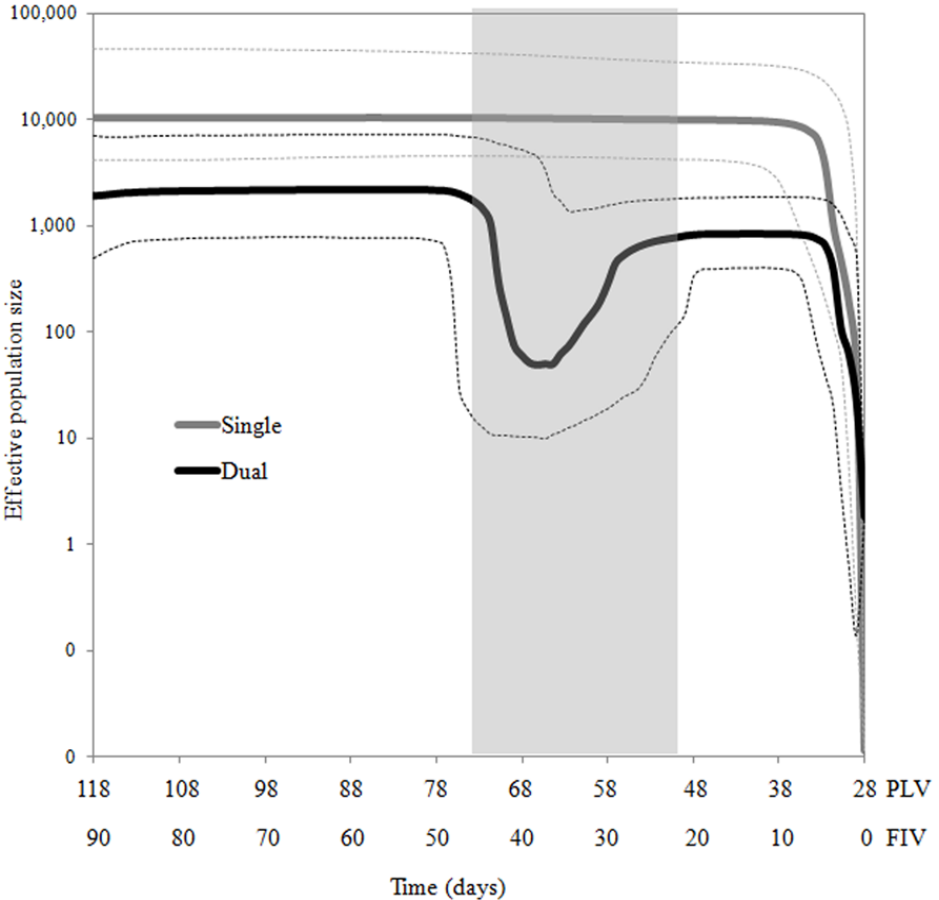
Figure 1. FIVC genomic diversity in dual and single infection. Bayesian skyline plot depicting dynamics of FIVC effective population size in single (grey) and dual (black) infections. Thick lines indicate median values and dotted lines indicate 95% confident intervals. The time scales are referenced to the day of PLV infection, and to the day of FIVC infection, which occurred 28 days after cats were infected with PLV. Shading highlights severe constriction of effective population size, indicative of a population